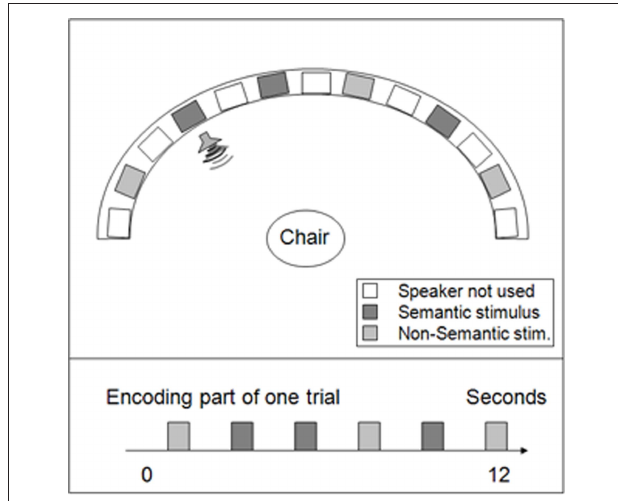
FigurE 1 | Auditory spatial memory task: setting and procedure. Top view of the auditory spatial memory array. Thirteen speakers were placed at regular intervals along the semi-circular array. Semantic and non-semantic sounds were presented for 1 s in randomized order at a 1-s ISI.